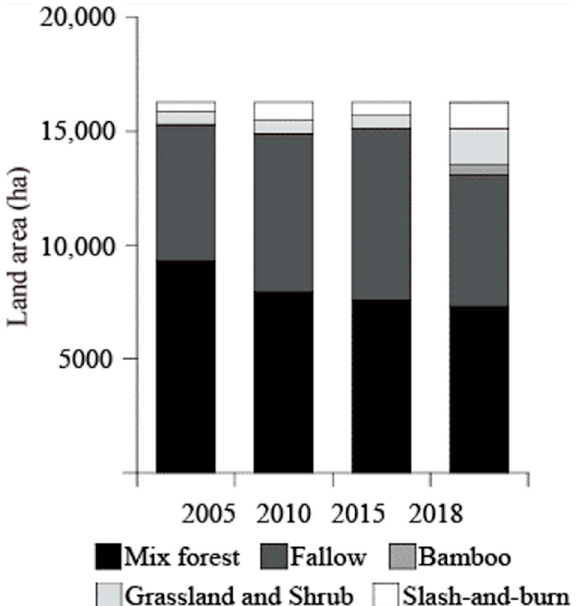
Figure 2. Land and forest cover dynamics in the villages of Houaykhing and Houayha, 2005–2018 (Data from Hiratsuka et al. [23]).